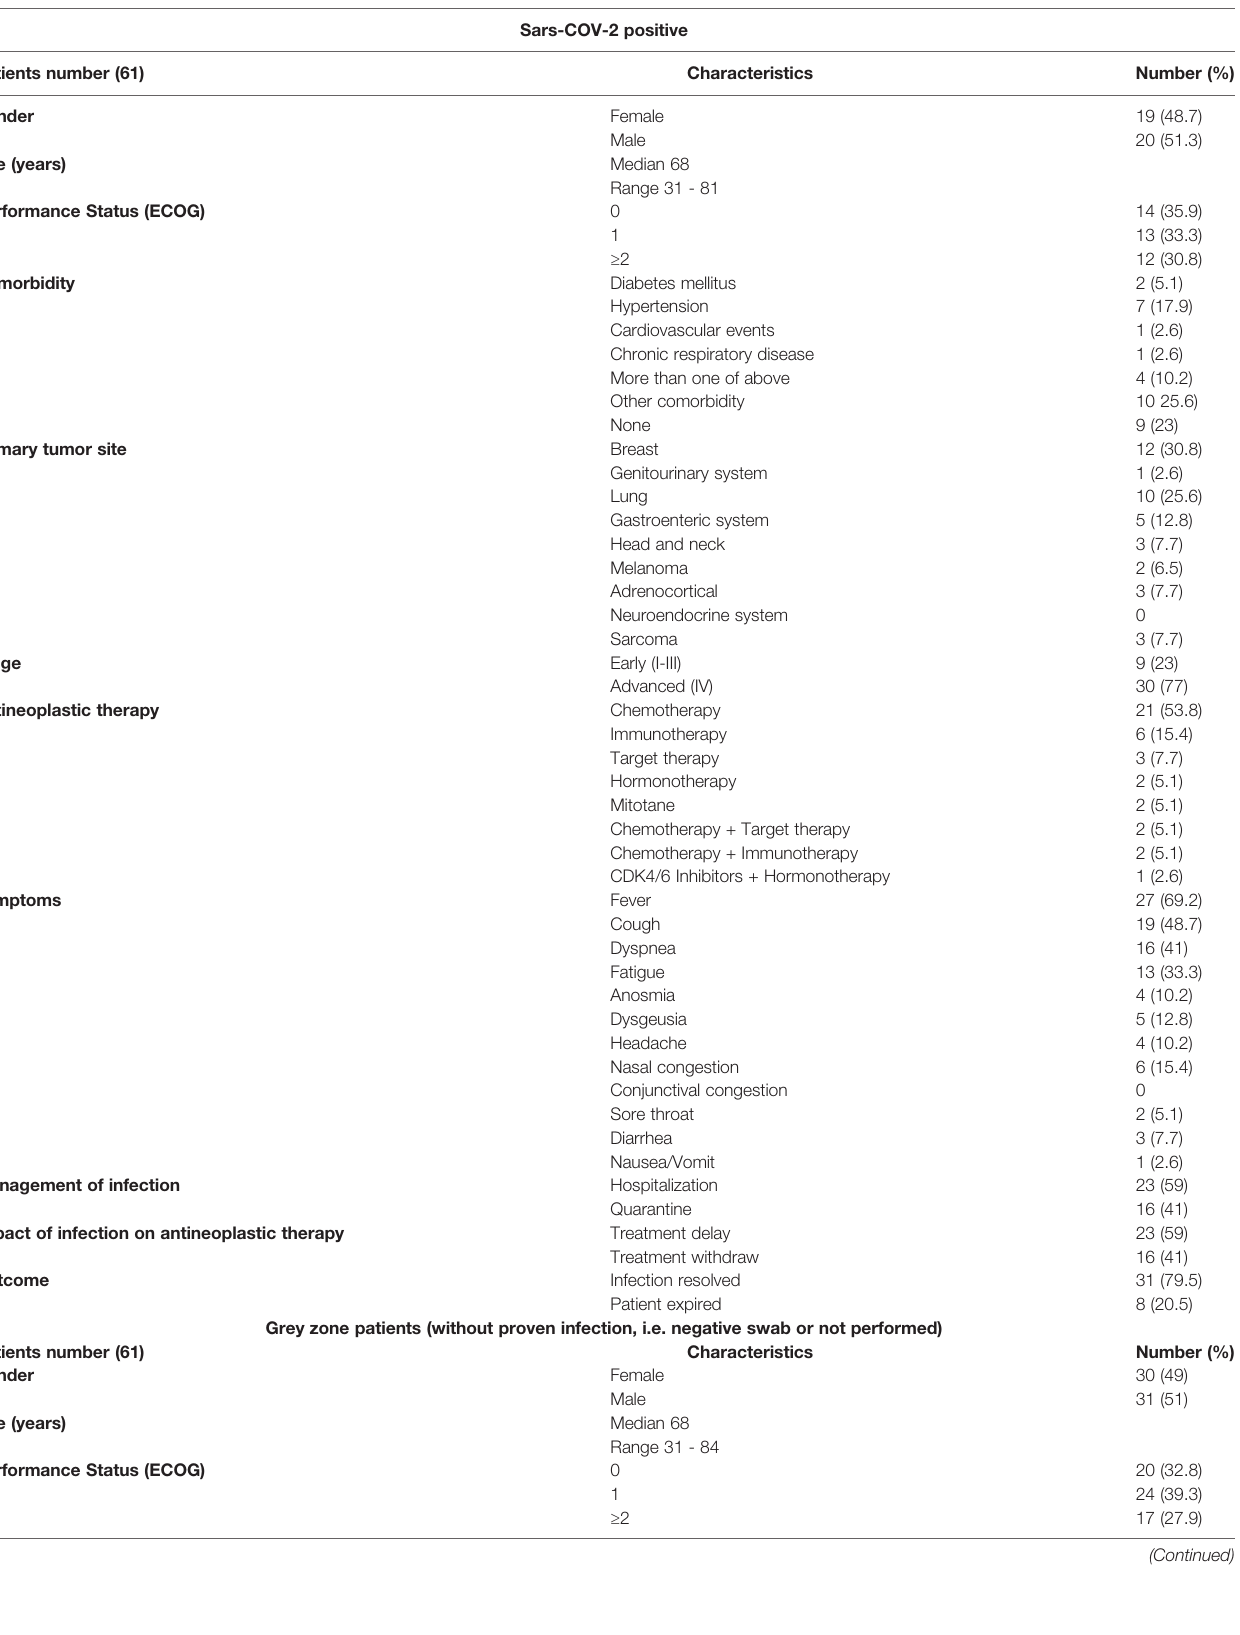
TABLE 2 | Characteristics of Sars-COV-2 -positive and grey zone